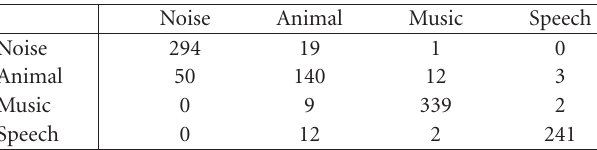
Table 3: Confusion matrix (rows give the decision and columns give the true class) for NRAF short with GMM. This gave an accu- racy of 90.21%.